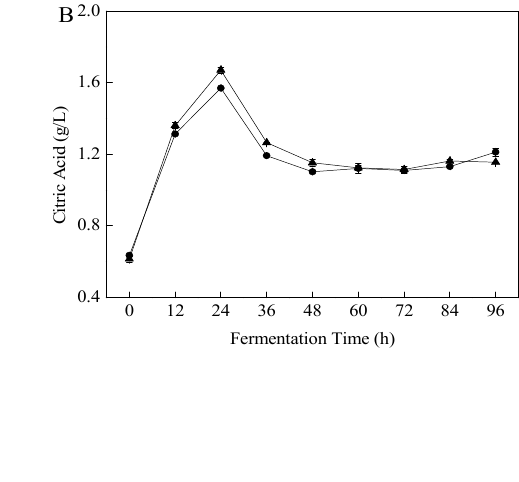
Figure 2. Reducing sugar consumption and ethanol production during 96 h. The and △ indicate reducing sugar consumption in S. cerevisiae SC125-fermented apple juice and the control. The • and (cid:78) indicate ethanol production in S. cerevisiae SC125-fermented apple juice and the control. The organic acids in fermented fruit beverages have a significant impact on the flavor, stability, and quality of the beverages, and they also influence their pH and acceptability [17]. The change profiles of the main organic acids during the apple beverage fermentation process are shown in Figure 3. Malic acid was the most abundant organic acid in apple juice and the fermented beverage (Figure 3A). The initial content of malic acid in apple juice was 3.64 ± 0.01 g/L. Compared with control, the S. cerevisiae SC125-inoculated apple juice showed higher malic acid content throughout fermentation, and 4.16 ± 0.03 g/L malic acid was detected after 96 h of fermentation. This could be related to the GABA shunt pathway in S. cerevisiae SC125. In yeast, GABA can be catabolized to succinate semialdehyde (SSA) by GABA transaminase, followed by conversion of SSA to succinate, which subsequently feeds into the tricarboxylic acid (TCA) cycle [26]. Succinate then undergoes a series of catalytic reactions to form malic acid. Meanwhile, malic acid can provide a delightful sourness and act as a flavoring agent to create a smoother, more natural taste [27].